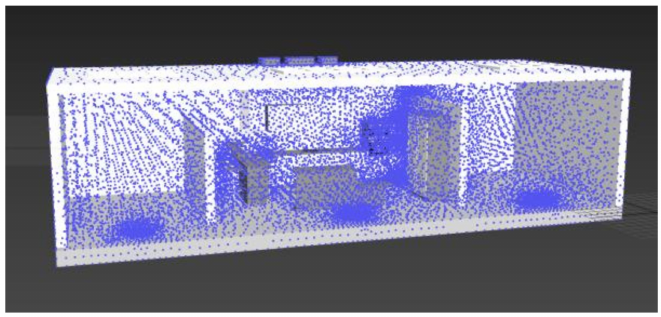
Figure 7. Import BIM geometry from Revit and CFD nodal results from Autodesk CFD.